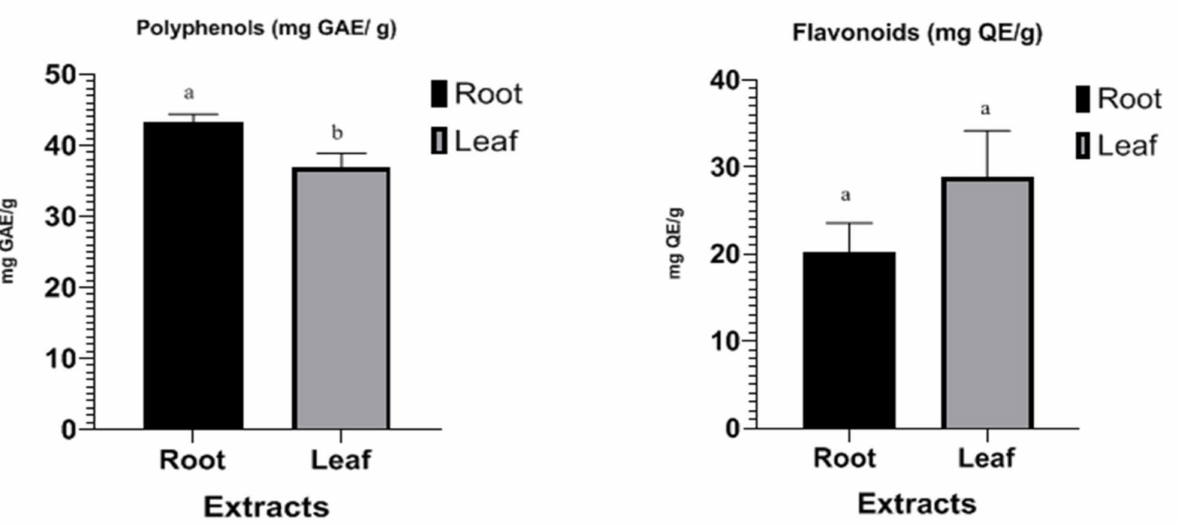
Figure 1. Histogram of polyphenol and flavonoid content of extracts of Anchusa italic Retz. Sta- tistically significant differences between the means are indicated by a and b ( p <